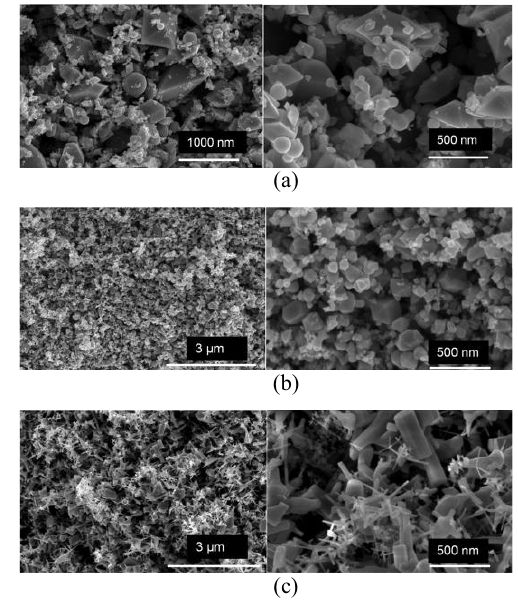
Fig. 2. Microscope images of powders.